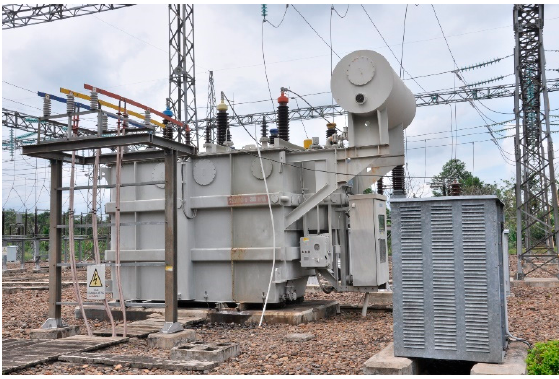
Figure 1. Example of 150/20 kV transformer with a capacity of 60 MVA.